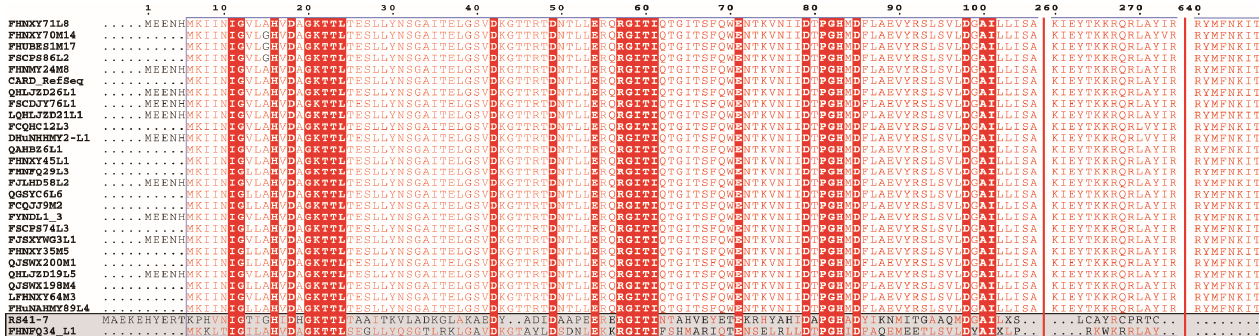
Figure 2. Multi-sequence alignment of tet(M) sequences of Lactiplantibacillus plantarum RS41-7 and Lactobacillus gasseri FHNFQ34_L1 (the bottom two sequences) with the tet(M) sequences of other strains in this study.